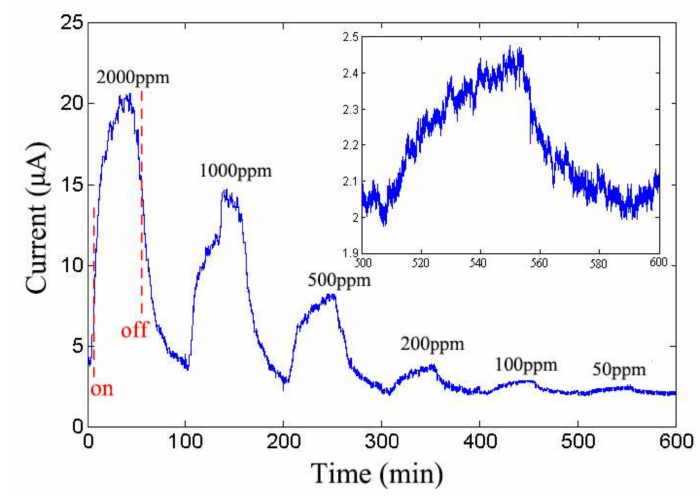
Figure 6. Evolution of nanodevice current with respect to the concentration of CO gas at 200 ◦ C (inset is the zoom-in image when the CO concentration is 50 ppm).